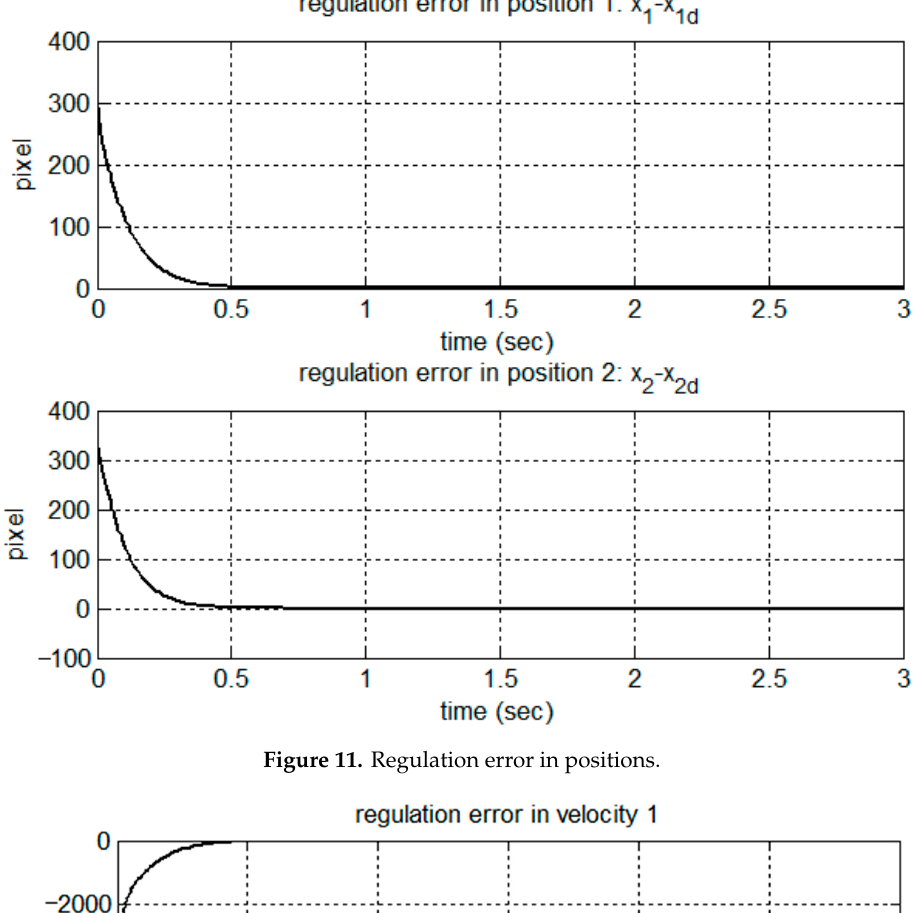
Figure 10. Trajectories in the task space.